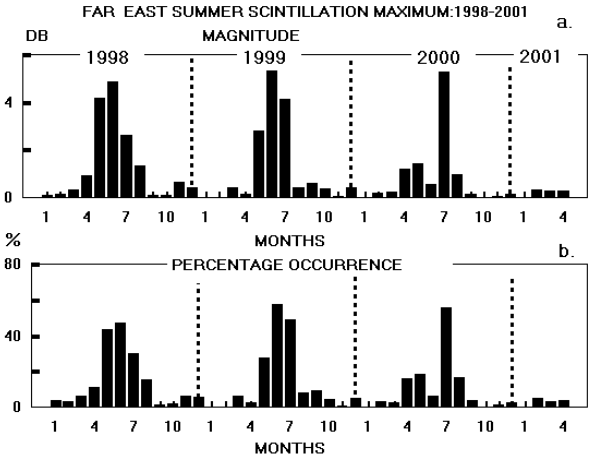
Fig. 3. The Far East summer scintillation anomaly in the average magnitude and the percentage occurrence number of scintillation events in the VHF range as recorded at Kokobunji over a three-year period.